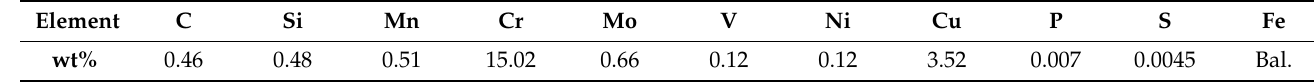
Table 1. Elemental composition of